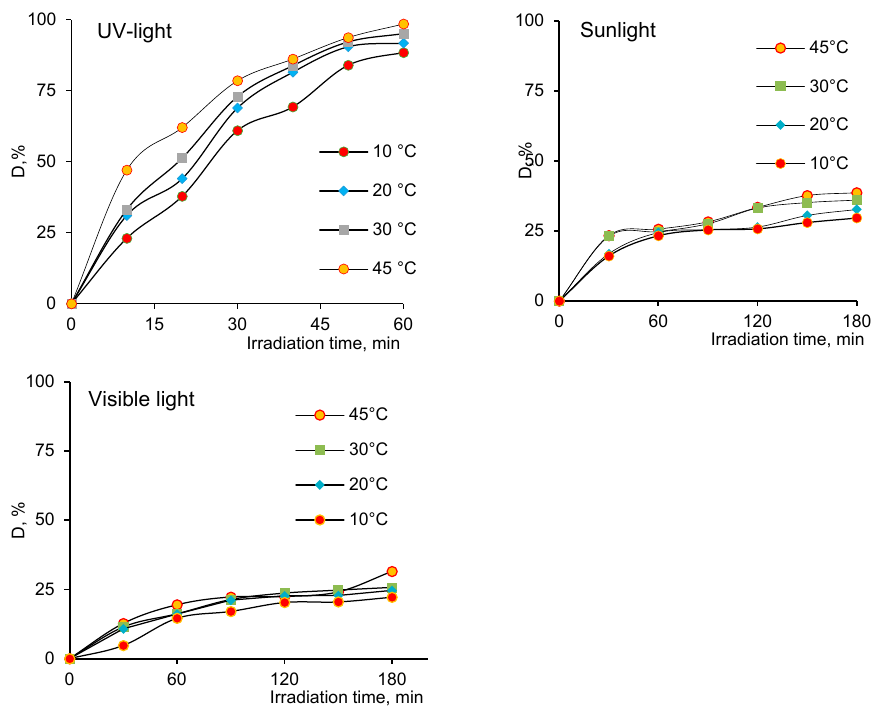
Figure 5. Influence of temperature on the degree of AY degradation (D, %) depending on the radiation source (nanoparticle mass—50 mg, AY concentration—10.0 mg/L).